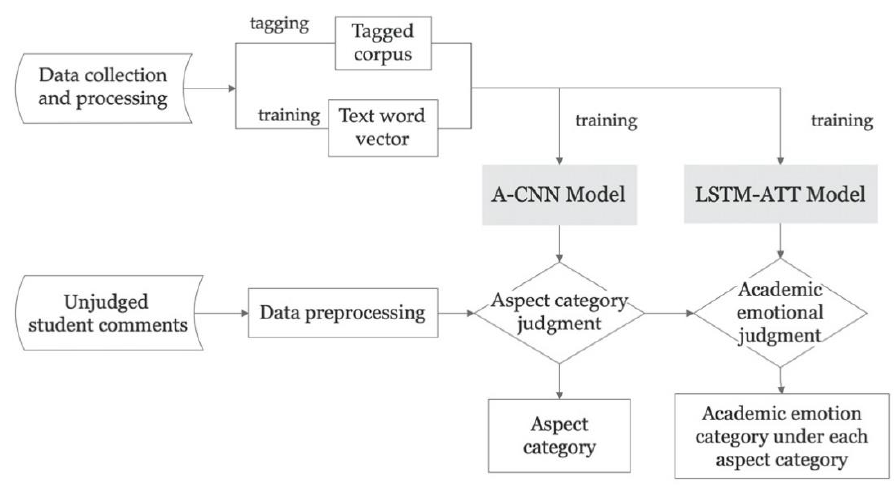
Figure 2. Academic emotion automatic recognition pipeline framework.